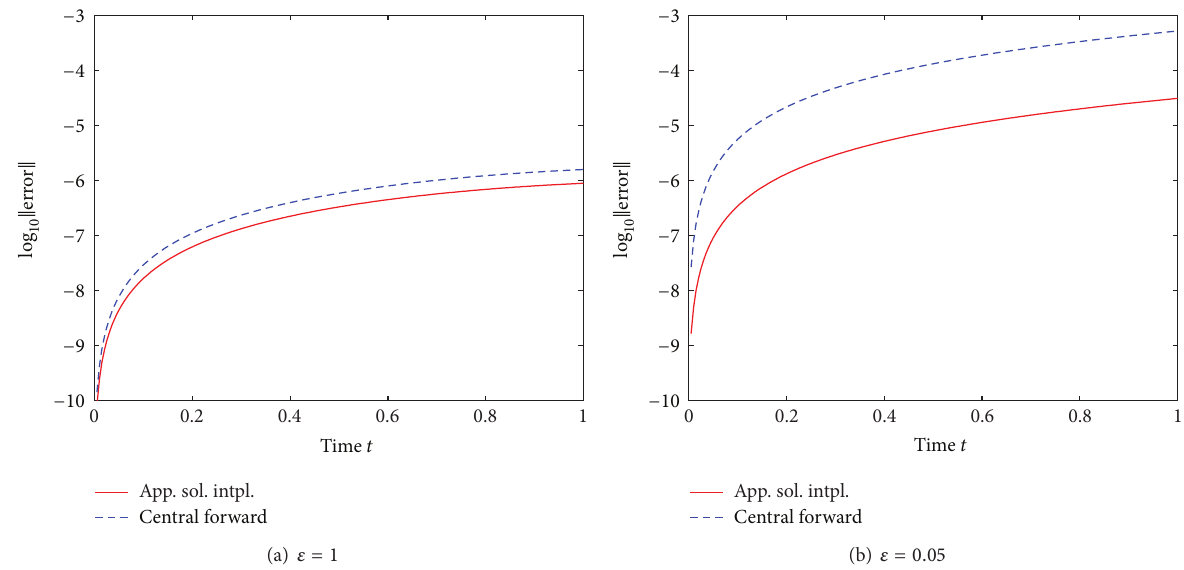
Figure 5: Time evolution of the errors in numerical solutions for 𝑢 𝑡𝑡 = exp (−𝑥/𝜀)𝑢 𝑥𝑥 , 0 ≤ 𝑥 ≤ 1 . The exact solution 𝑢 = (1 + 𝑥)𝑡 2 + 𝑥𝑡 + 𝑥 + 2(−𝜀 2 + 2𝜀 3 + (−𝜀 + 𝜀 2 )𝑥 + (𝜀 2 − 2𝜀 3 + 𝜀 2 𝑥) exp (𝑥/𝜀)) is used to generate the initial/boundary conditions and measure the errors.